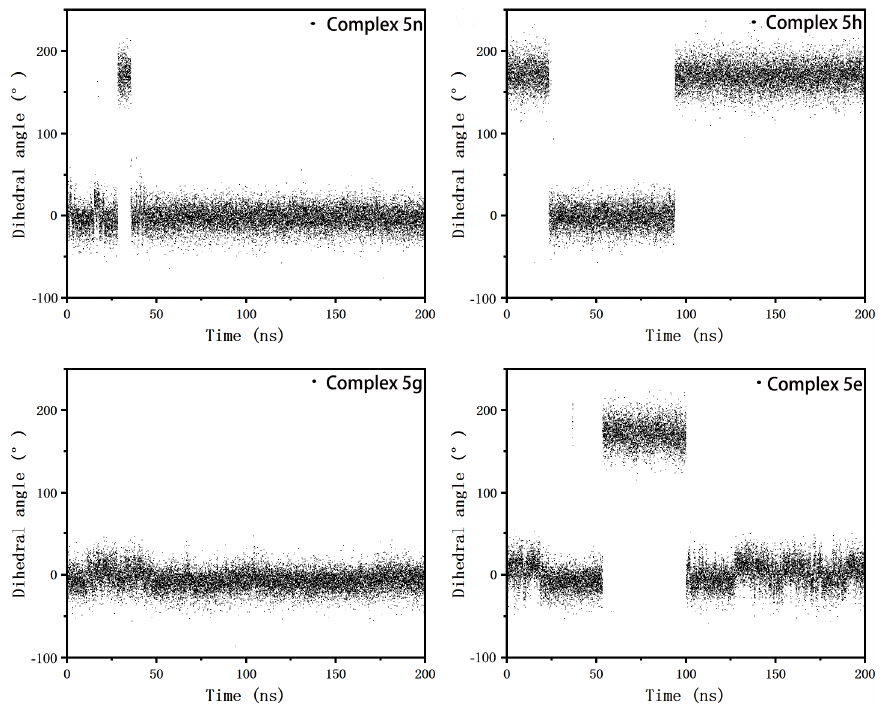
Figure 11. The variations of the dihedral angles reflecting the 4-imino directions in four complex systems with simulation time.